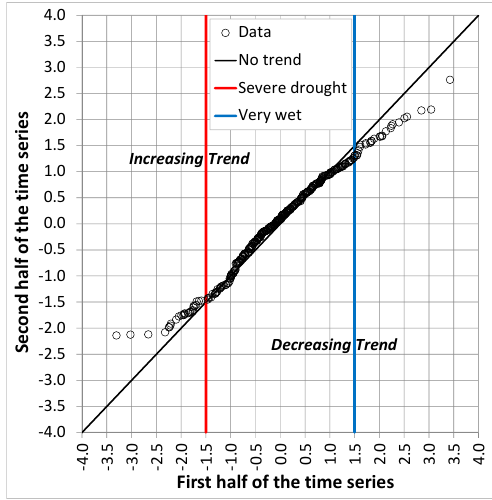
Figure 1. Example of the Innovative Trend Analysis (ITA) proposed by Ş en [39].